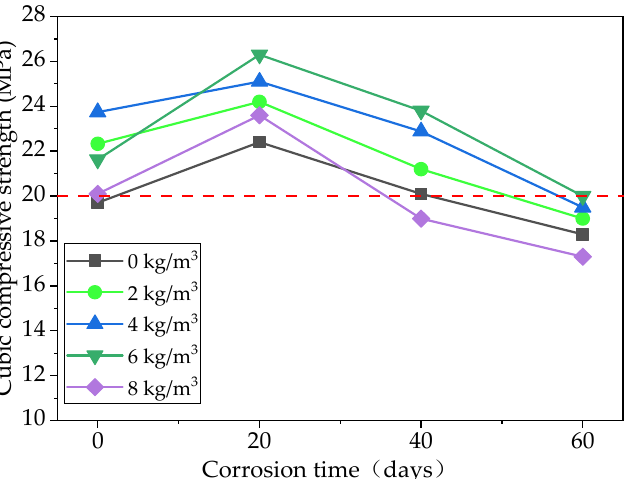
Figure 15. The cubic compressive strength of specimens with different levels of basalt fiber content